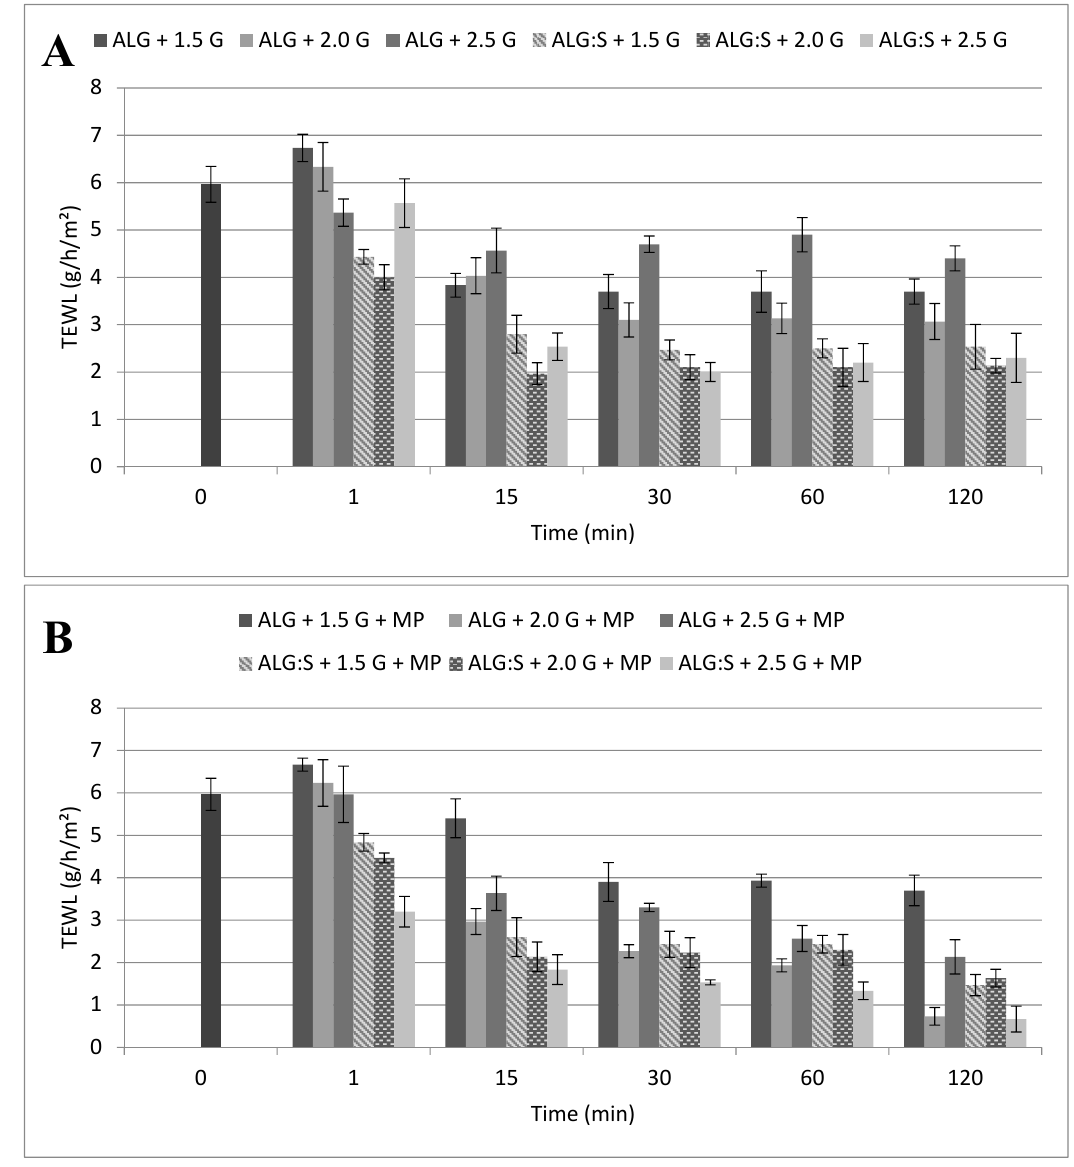
Figure 5. Skin barrier quality (transepidermal water loss—TEWL) after application of sodium alginate-based films ( A ) without and ( B ) with microspheres containing encapsulated Calendula officinalis flower extract: ALG + 1.5 G, ALG + 2.0 G, ALG + 2.5 G—samples based on sodium alginate containing 1.5%, 2%, and 2.5% of glycerin, respectively. ALG: S + 1.5 G, ALG: S + 2.0 G, ALG: S + 2.5 G samples based on sodium alginate and starch containing 1.5%, 2%, and 2.5% of glycerin, respectively. The measured skin color is expressed as an XYZ-value and was calculated into L*a*b related value. L* gives information about the black-white axis and skin brightness, while a* and b* are the coordinates in the color space—a* locates the values on the red-green axis, whereas b* shows the color position on the blue-yellow axis. Therefore, the a* values were considered in this